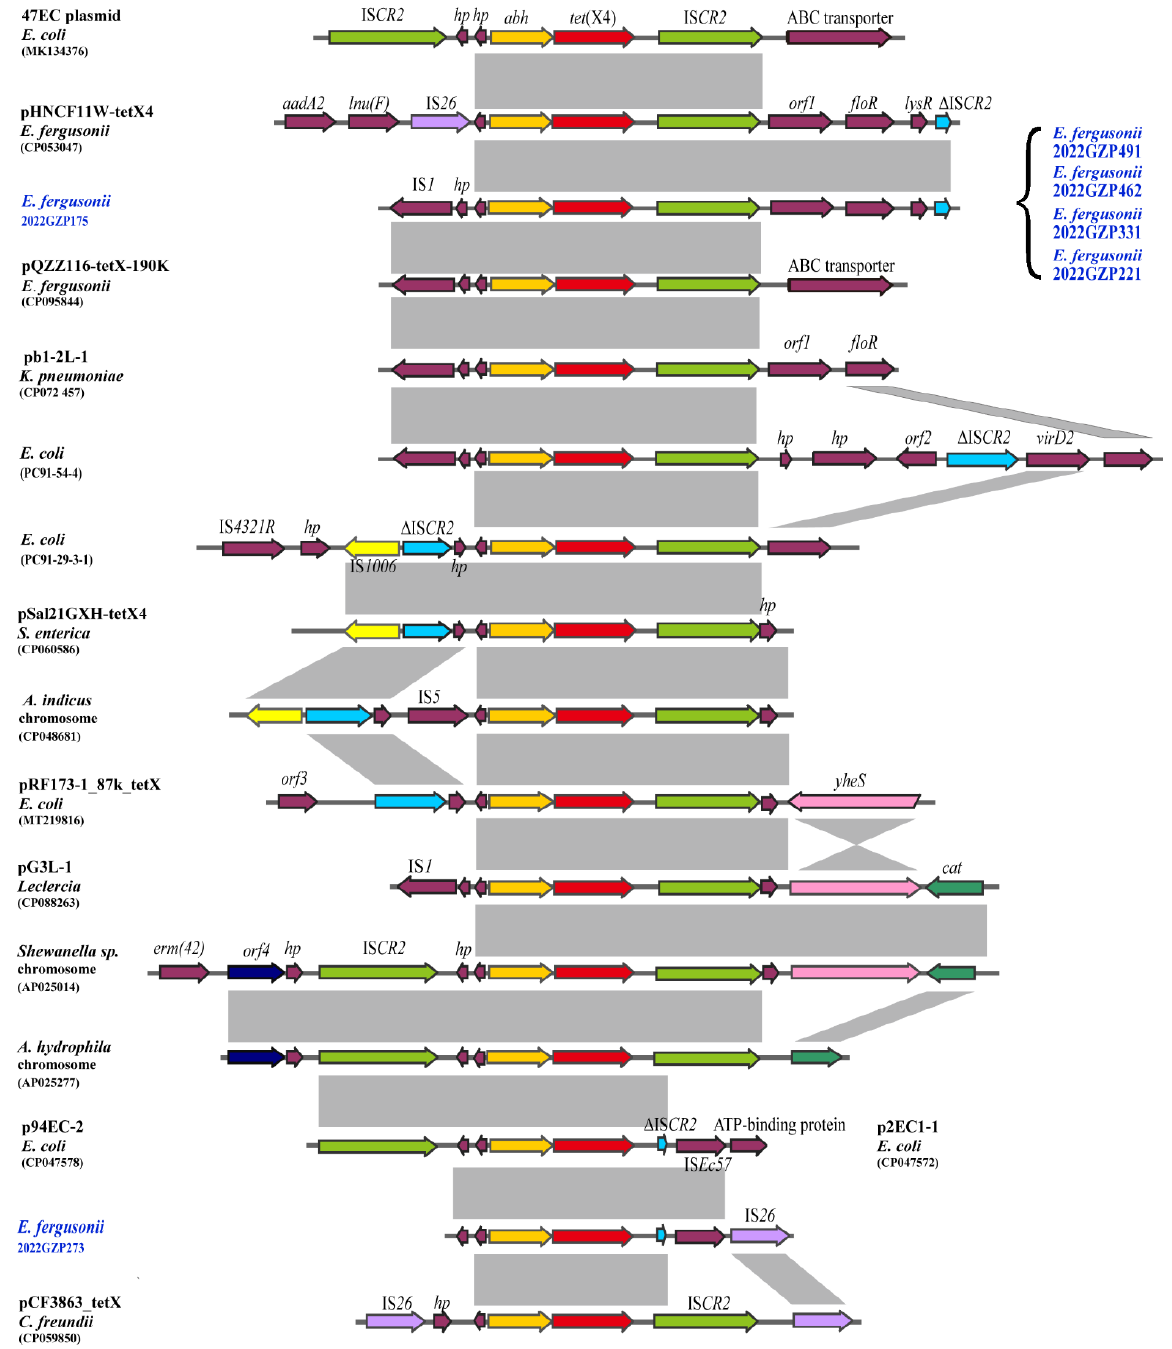
Figure 2. Genetic environments of the tet (X4) gene in six Escherichia fergusonii isolates isolated from 50 pig farms in China. The arrows indicate open reading frames. Light-gray shading denotes homology regions. Strains in this study are in blue font.